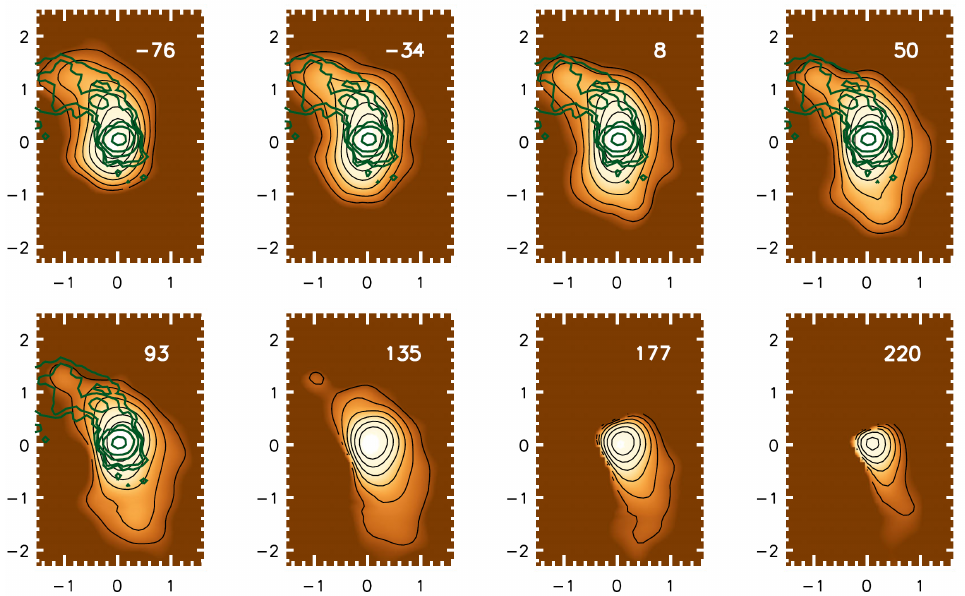
Figure 3. Channel maps along the H α emission-line profile of the radio galaxy Arp102B, with velocities displayed in white at the top right corner of each map (in units of kms − 1 , [68]). The flux distribution maps show a spatial correlation with the radio jet, represented by the green contours from VLA observations at 8.4 GHz. We have interpreted this emission to be related to outflowing gas pushed aside by the jet moving close to the sky plane, thus displaying blueshifted and redshifted velocities originated in the gas surrounding the radio jet. X and Y-axis are in arcsec and are centered at the galaxy